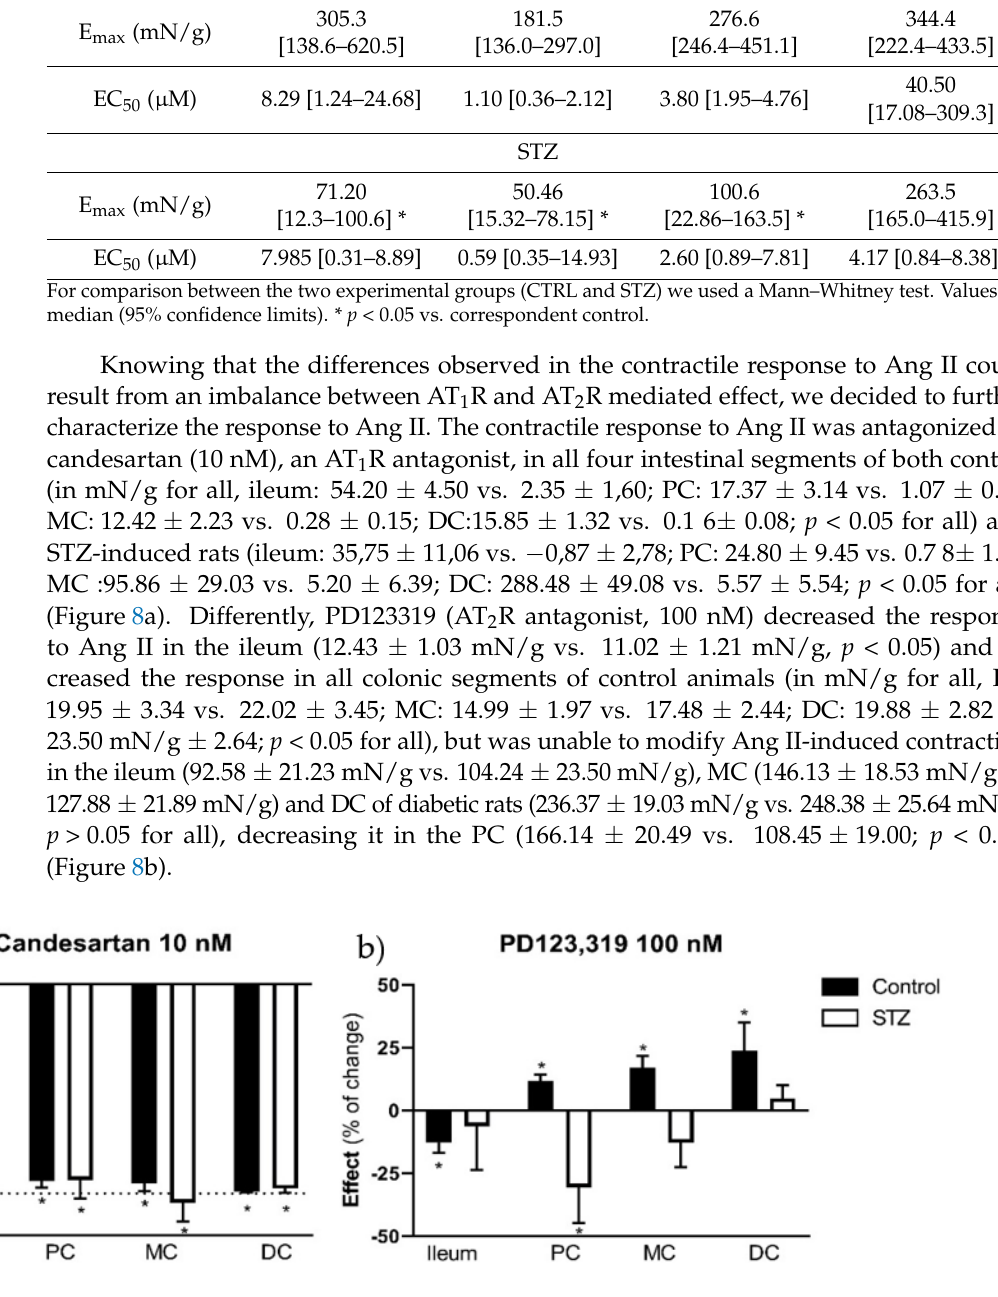
Figure 8. Angiotensin II contractile effect (expressed as percentage of change) in the ileum, proximal colon (PC), middle colon (MC) and distal colon (DC) of control (CTRL, n = 5–8) and